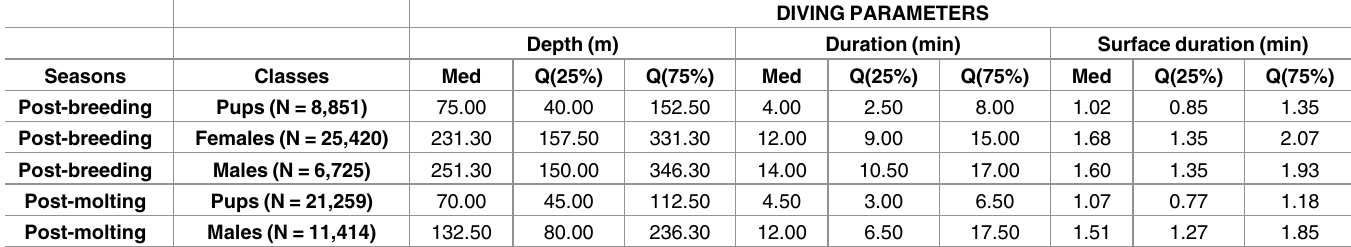
Table 2. Diving parameters for hooded seal adult males, adult females and pups during the post-breeding and the post-molting seasons. Med. = median,and Q(25%) and Q(75%) = the 25% and 75% quantiles,respectively. The numberof dives per age/sex class and season is detailedin parenthesis. These dives were conductedby 3 males, 9 females and 6 pups in the post-breeding period and by 2 males and 5 pups in the post-molting period.